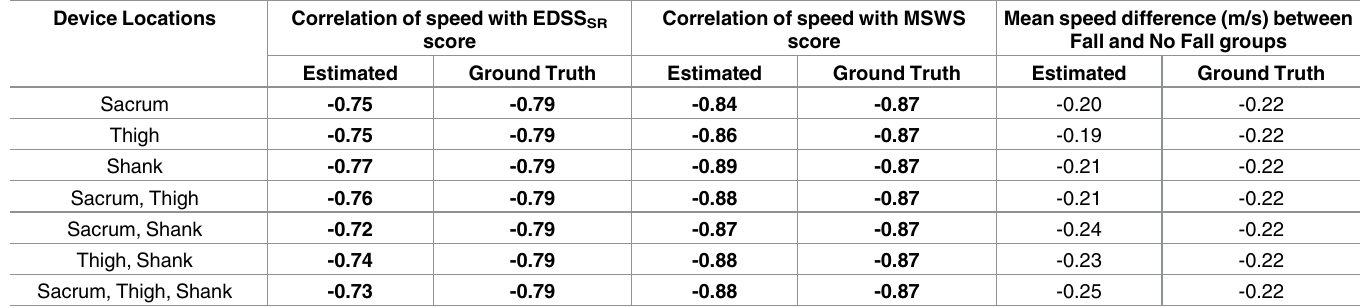
Table 4. Relationship between walking speed and MSWS score, EDSS SR score, and fall history. Device